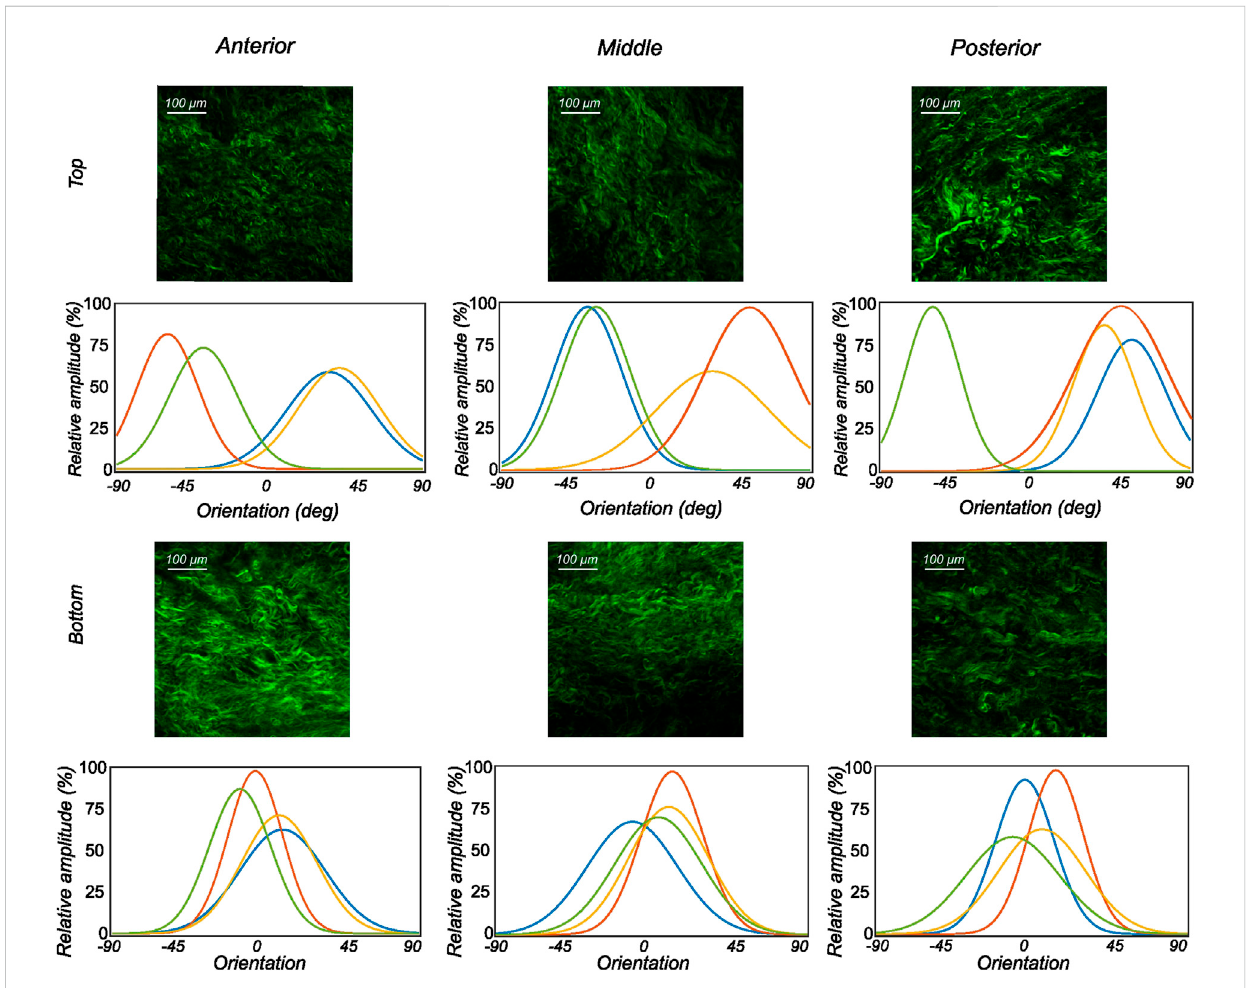
FIGURE 8 The orientation distribution computed on each image slice of individual image stacks was averaged through the thickness to obtain the representative collagen orientation distribution of the sample. Here, the computed orientation distribution for samples excised from medial menisci is shown. The top and bottom pro fi les represent the samples from the top and bottom samples, respectively. Column-wise, they represent the anterior, mid-body, and posterior